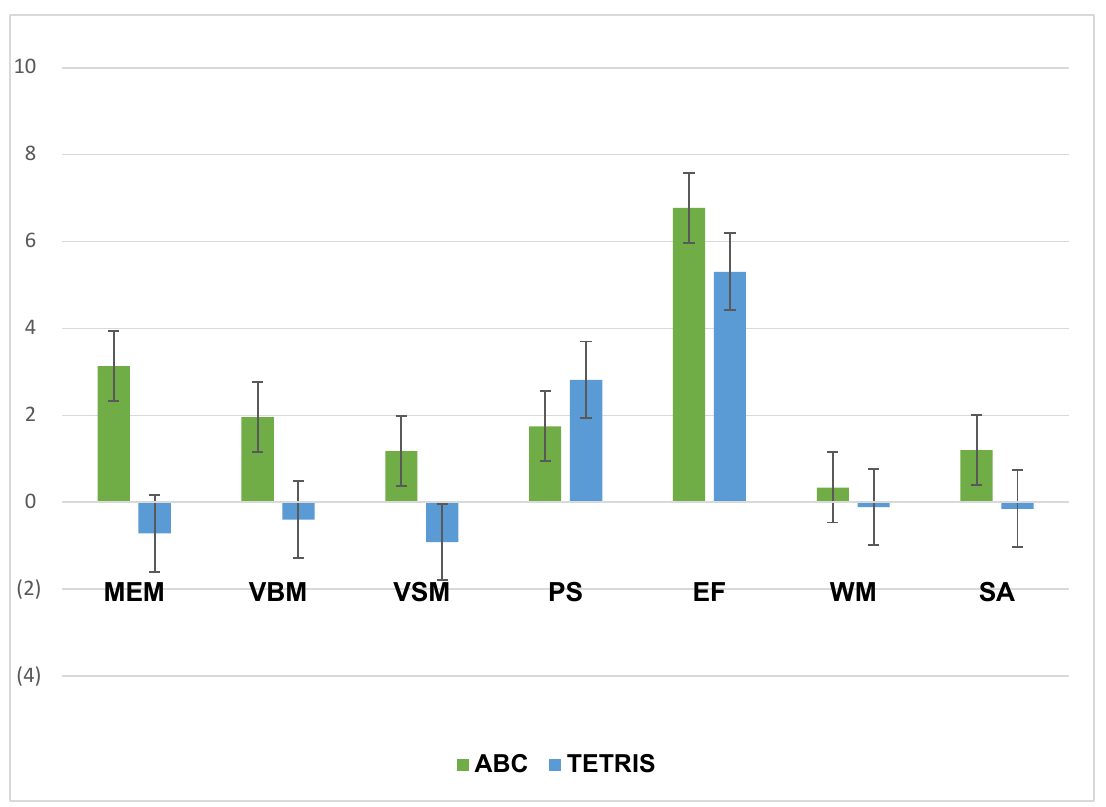
Figure 4. Individual cognitive test change score by group. The treatment (ABC) group showed greater improvements in memory (MEM), verbal memory (VBM), visual memory (VSM), processing speed (PS), executive function (EF), and sustained attention (SA) relative to the control (Tetris) group. WM = Working Memory.